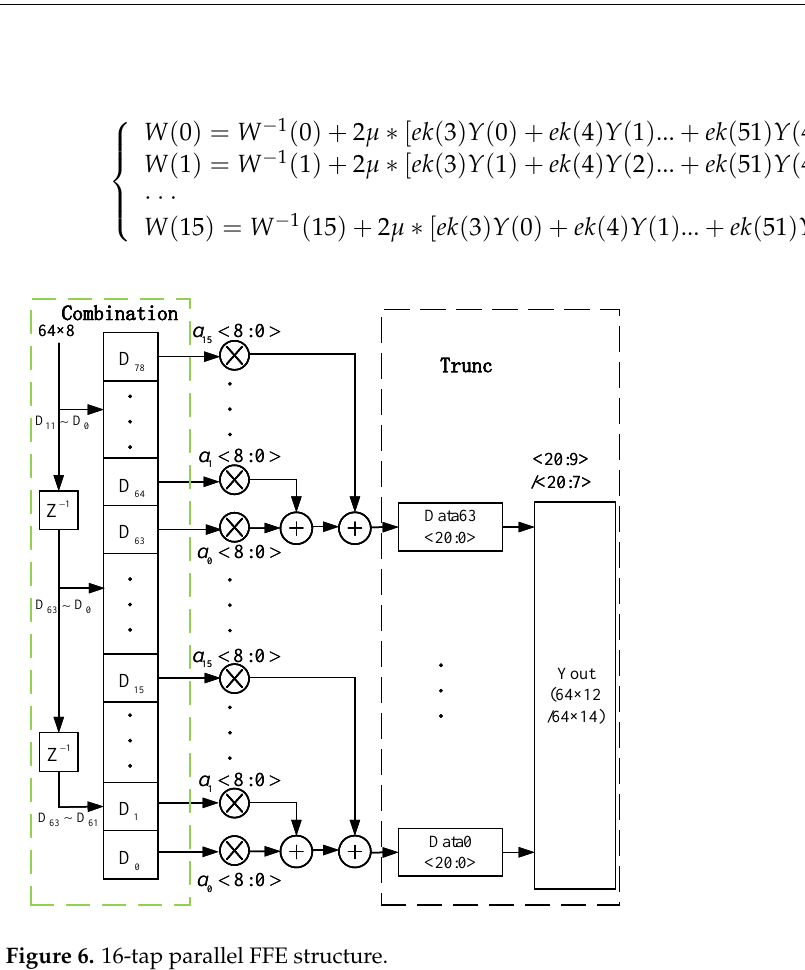
Figure 6. 16-tap parallel FFE